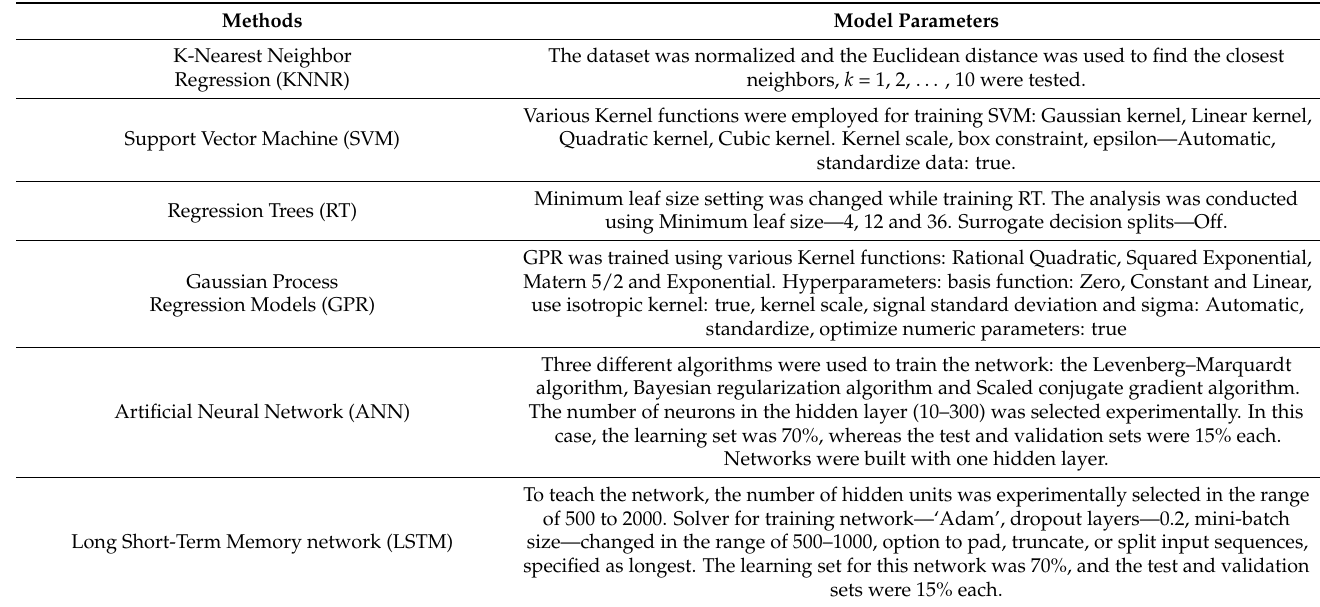
Table 2. Modeling parameters using the analyzed